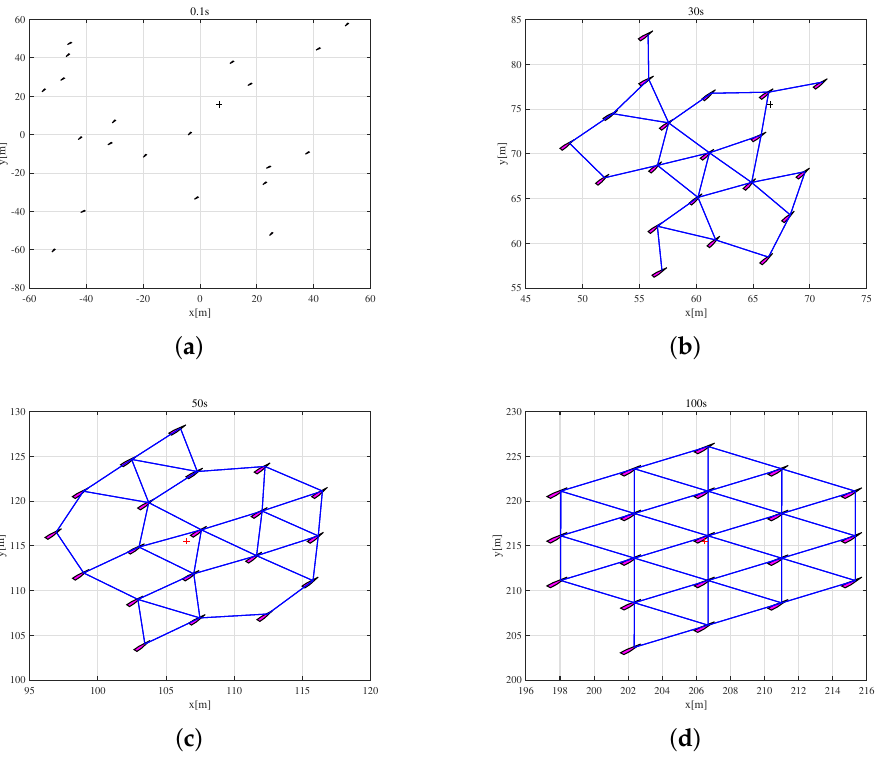
Figure 11. Motion instants of swarming/automated rendezvous by using proposed method in [36]. The blue ship shape and “+” represent the vessel and virtual leader, respectively. ( a ) t = 0.1 s. ( b ) t = 30 s. ( c ) t = 50 s. ( d ) t = 100